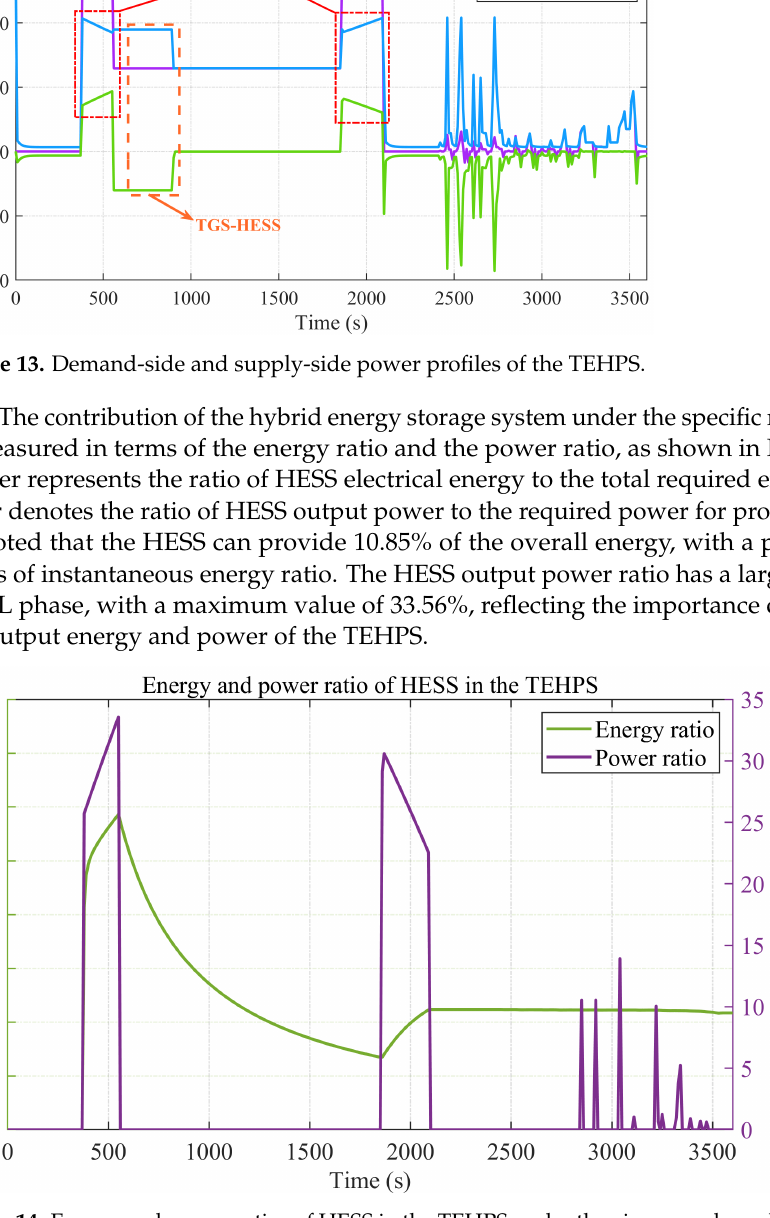
Figure 14. Energy and power ratios of HESS in the TEHPS under the air–ground amphibious